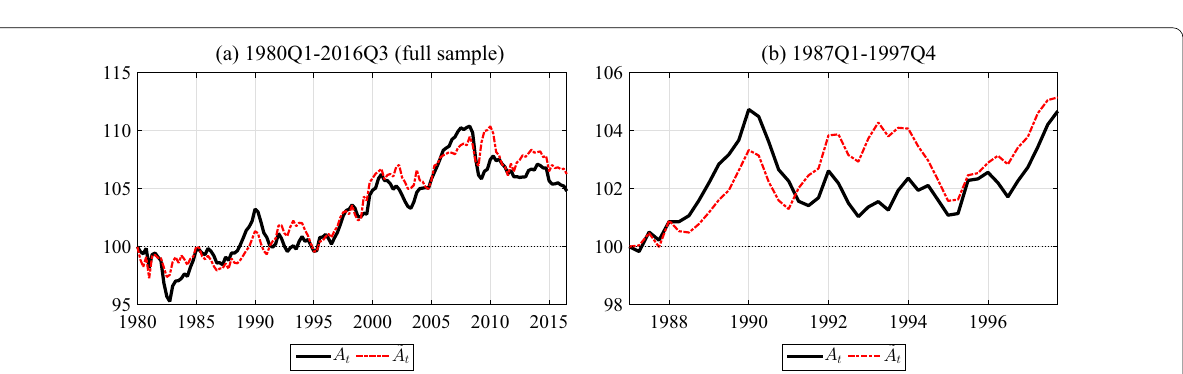
Fig. 20 Robustness: Productivity and utilization-adjusted productivity for ν = 0.5 . A t and ˜ A t are the efficiency and the utilization-adjusted efficiency wedge,